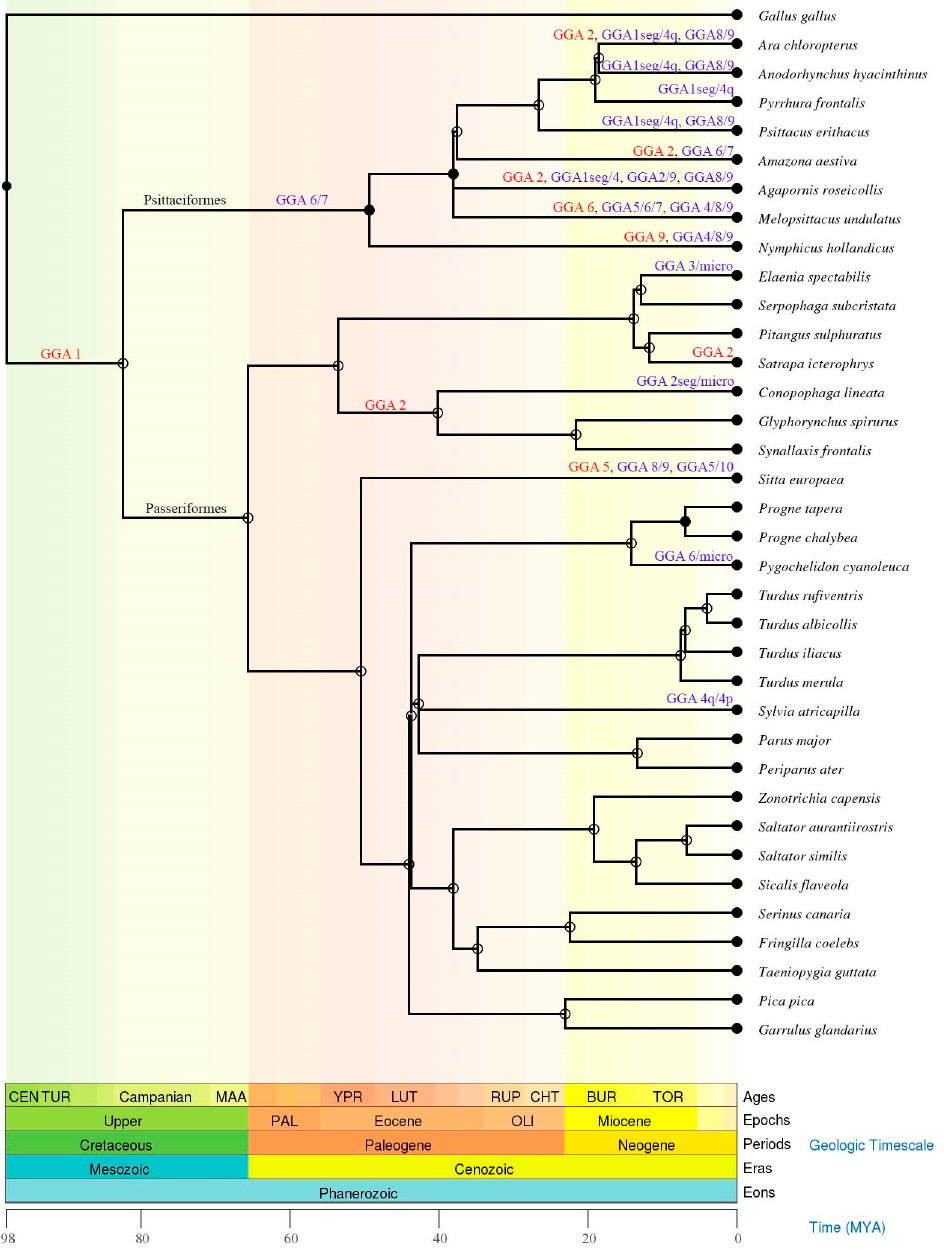
Figure 7. Chromosomal rearrangements in Passeriformes and Psittaciformes species analyzed with chromosome painting with Gallus gallus (GGA) probes (GGA1-10) or BACs clones corresponding to these GGA chromosomes. The phylogenetic tree was sourced from TimeTree databases (http://www.timetree.org, accessed on 12 May 2021) [70]. Rearrangements are represented by fissions (red) and fusions (blue). Seg = segment, q = long arm, micro = microchromosome.